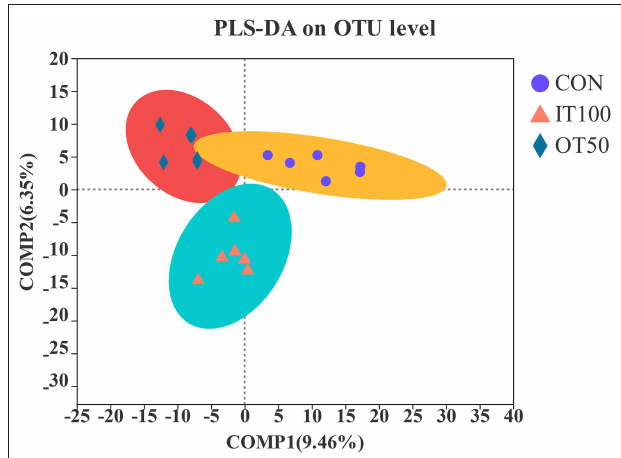
FIGURE 2 | Effects of inorganic and low level of organic trace minerals on the caecal microbiota at the 8th week of the experiment with hen layer at the age of 67 weeks ( n = 6). CON, control treatment, basal diet without supplementation of trace minerals; IT 100, basal diet supplemented with Fe (60 ppm), Cu (10 ppm), Mn (80 ppm), and Zn (80 ppm) as sulfates; OT 50, basal diet + 50% IT 100 trance minerals as amino acid